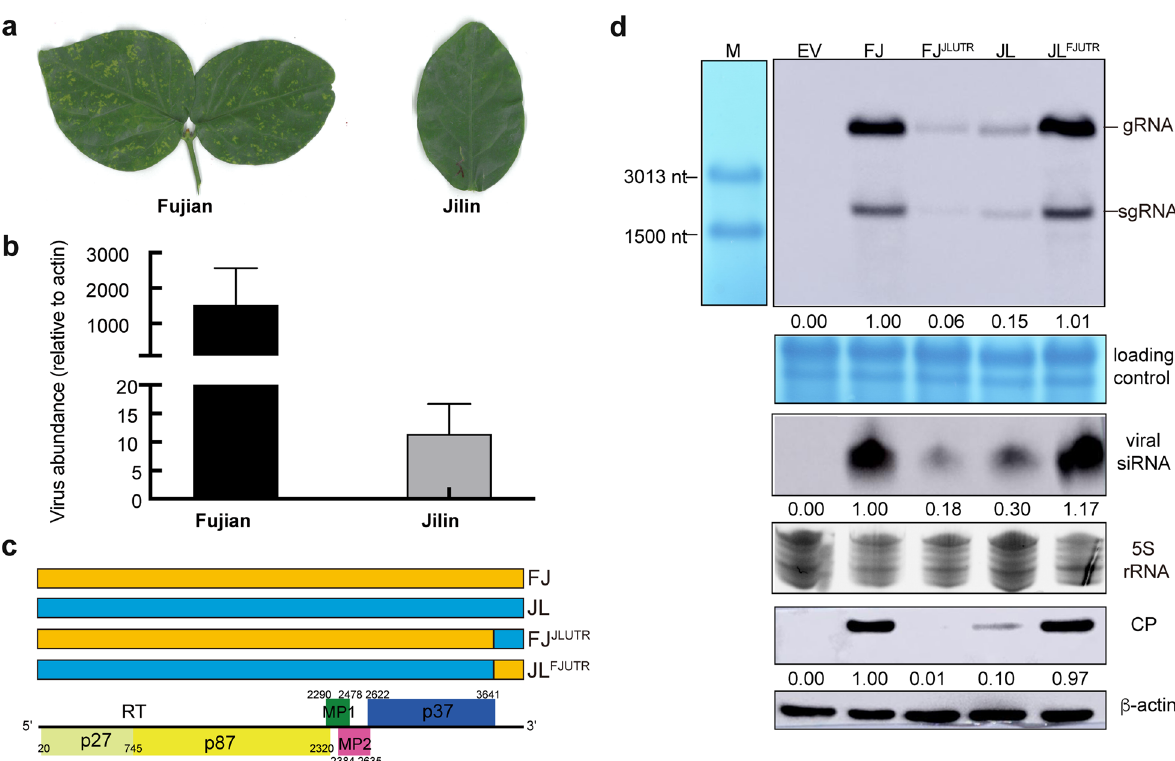
Fig. 4 Pathogenicity assessment of recombinant viruses constructed based on field symptoms difference. a Typical mosaic was observed on jasmine samples from Fujian but not Jilin Province. b Relative quantification of viral RNA by real time qPCR in jasmine leaves showed in a , relative abundance of JaVH was estimated by the 2 − ∆CT method using actin as control. c Schematic diagram of recombinant plasmids. The yellow box represents sequences related to JaVH‑FJ while the blue box represents sequences related to JaVH‑JL. d Detection of genomic RNA, subgenomic RNA, and virus derived siRNA of JaVH by Northern blotting and CP by Western blotting at 15 days post‑infiltration (dpi). A size marker and loading control are shown for